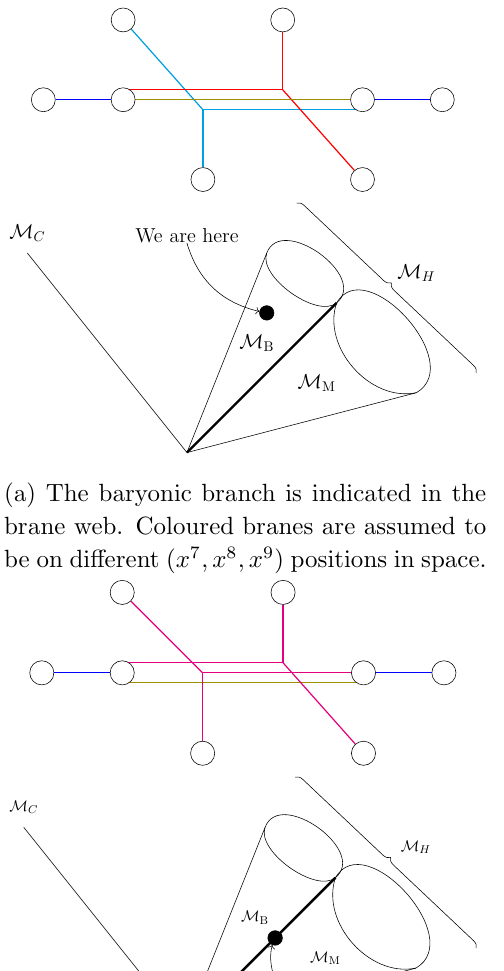
(c) The intersection of the baryonic branch and the mesonic branch is indicated in the brane web. Coloured branes are assumed to be on different ( x 7 , x 8 , x 9 ) positions in space. Figure 5 . Depiction of different phases in the brane web corresponding to different points in the moduli space of the gauge theory that lives on the